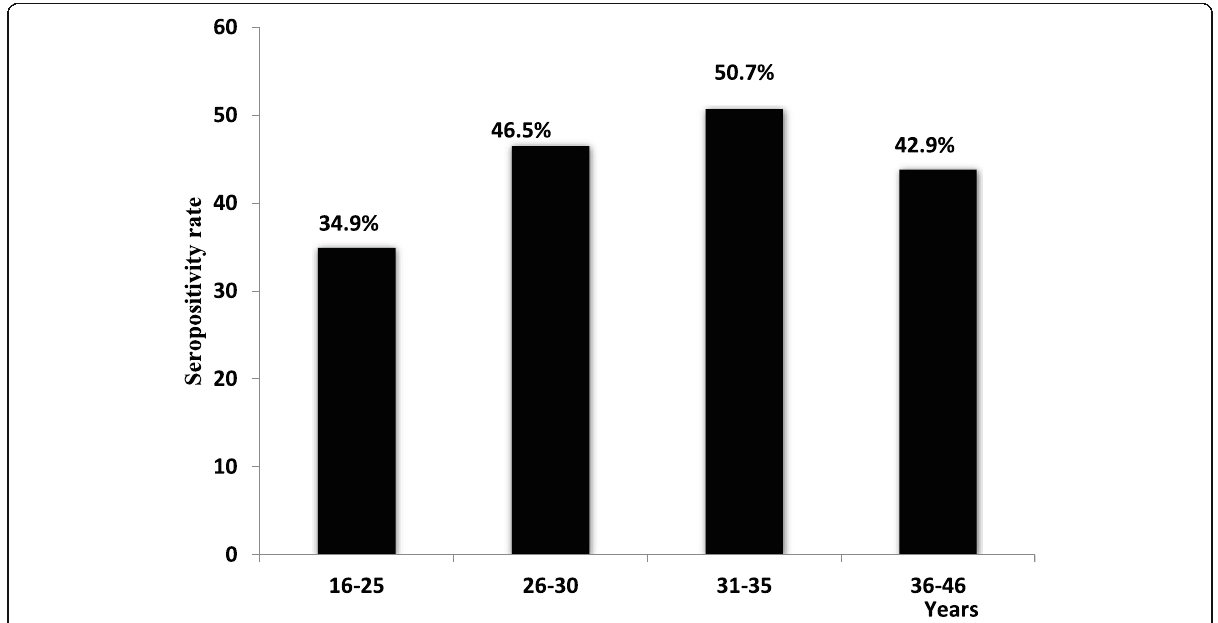
Fig. 2 Distribution of pregnant women by serostatus for IgG T. gondii antibodies in various age group (years)